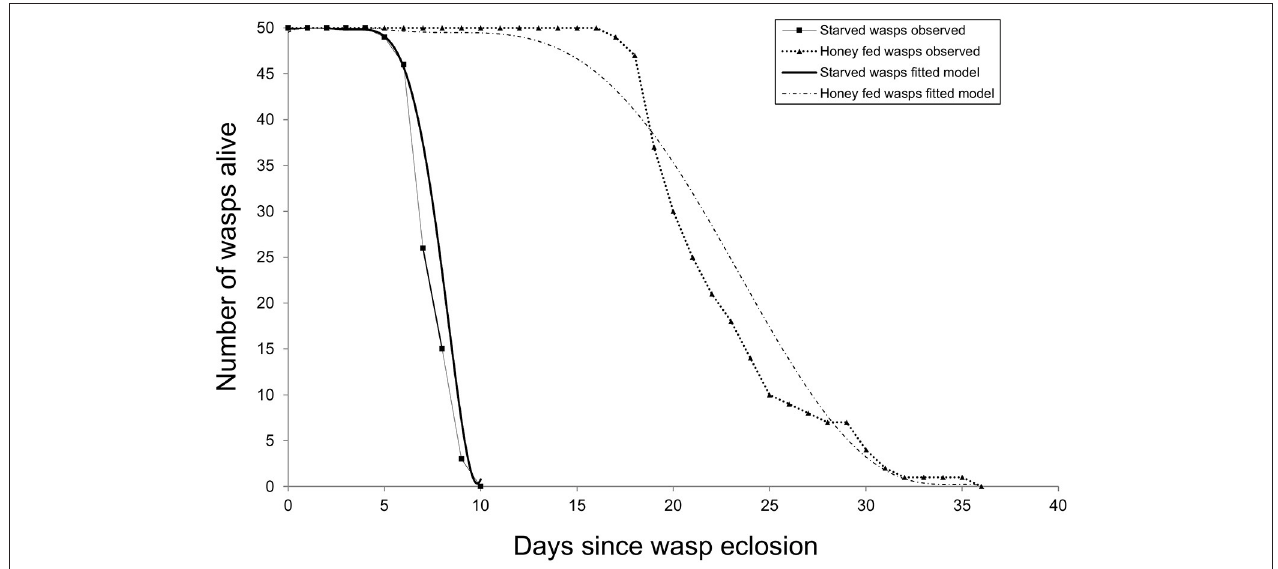
FIGURE 5 | Cohort survival of starved and honey-fed G. legneri females. After 1 week over 50% of starved individuals had died, honey-fed individuals lived around 2 weeks longer.